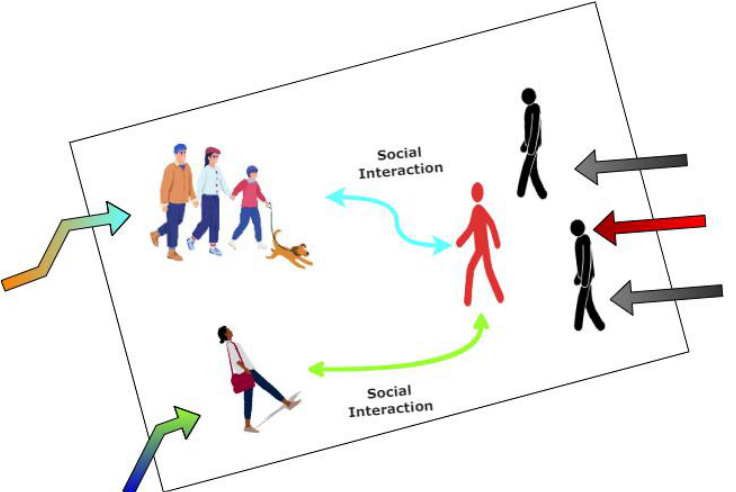
Figure 1. Pedestrians consider the future impacts of dynamic people involved in the scene when trying to make navigation decisions. The future trajectories of pedestrians need to be mentioned in a completely random way. As a result, both the spatial and temporal structure of the pedestrian- environment interaction must be taken into